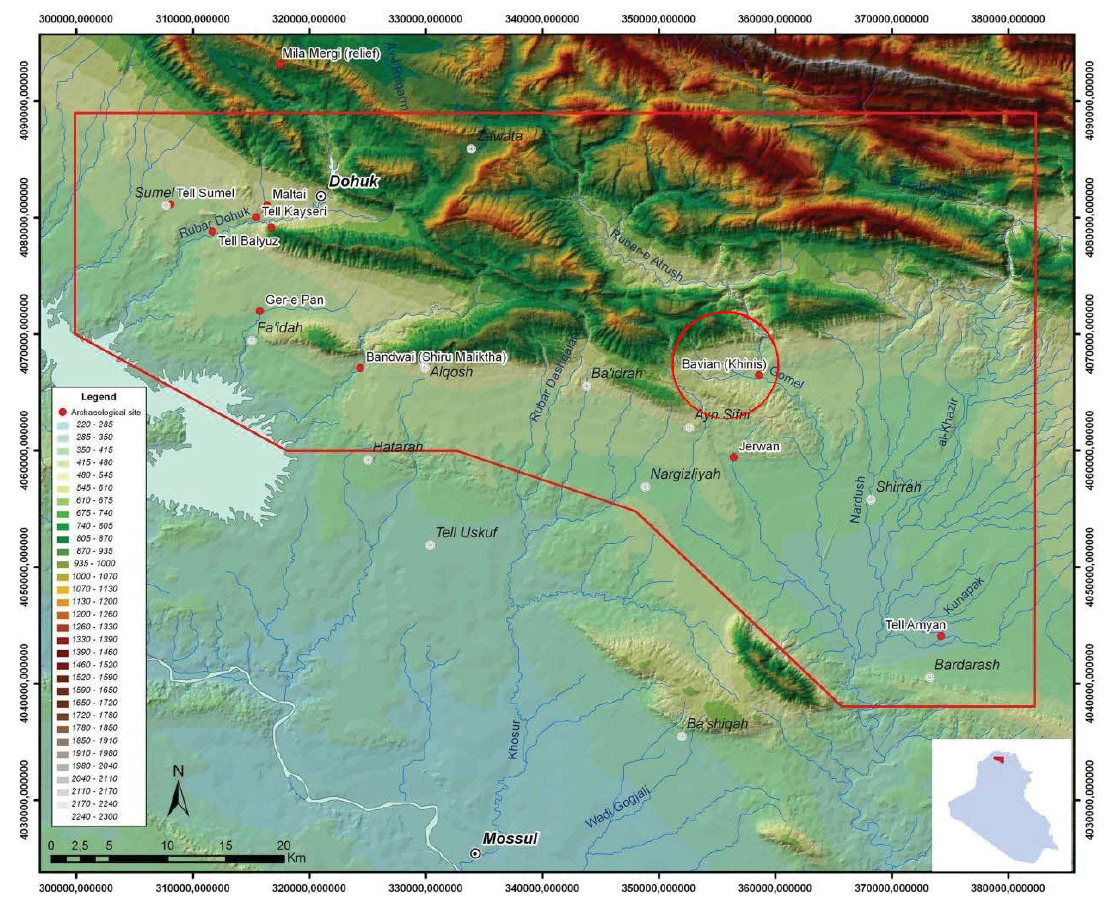
Figure 1. The borders of the “Land of Nineveh” in Iraqi Kurdistan (red line). The red circle highlights the area of Khinis, one of the areas of the Archaeological Park, subject of this case